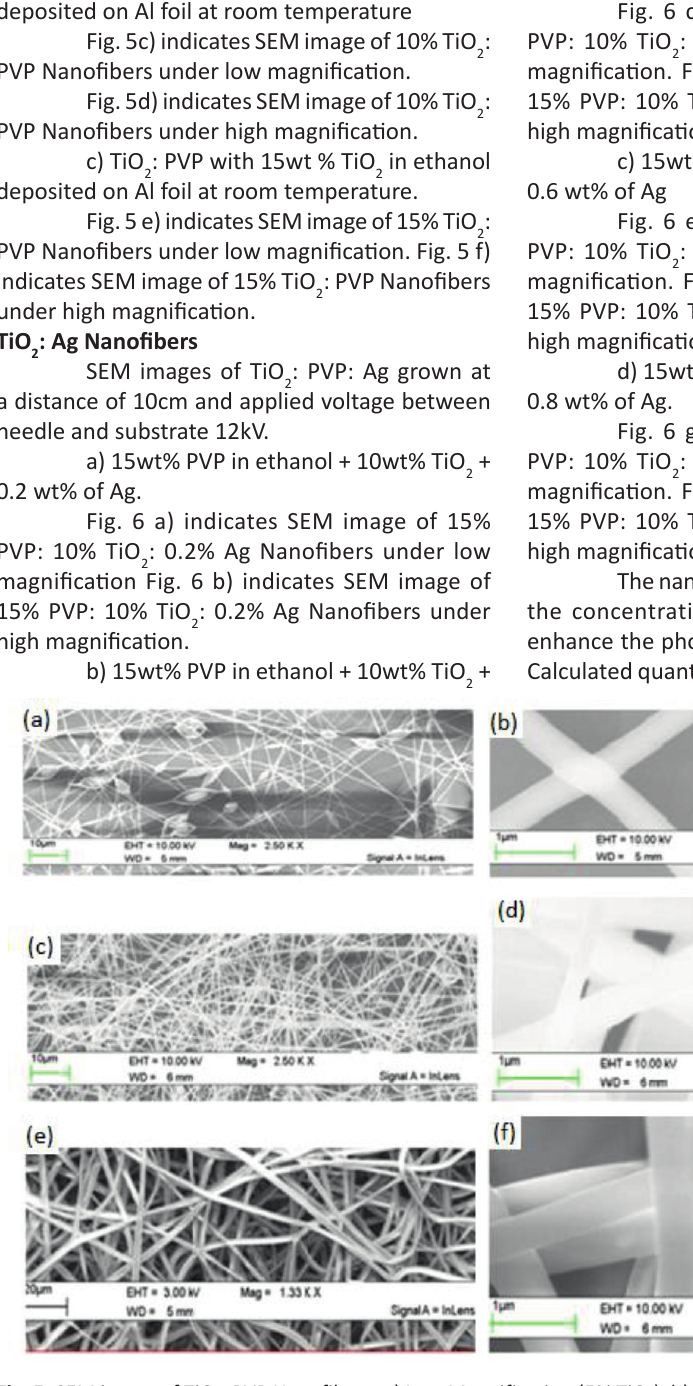
), b) High Magnification (5% TiO 2 ), e) Low Magnification (15% TiO 2